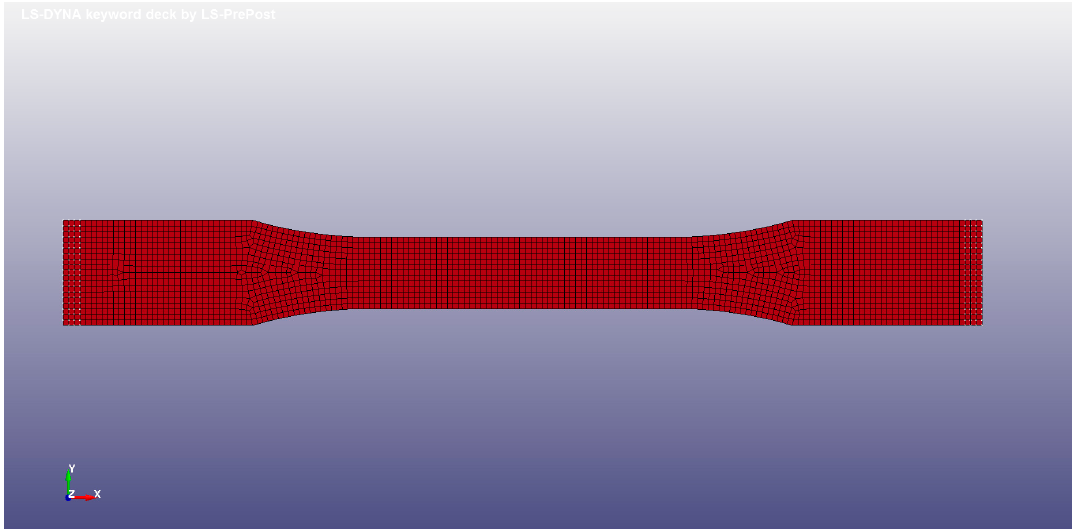
Figure 9. Tensile specimen element mesh.